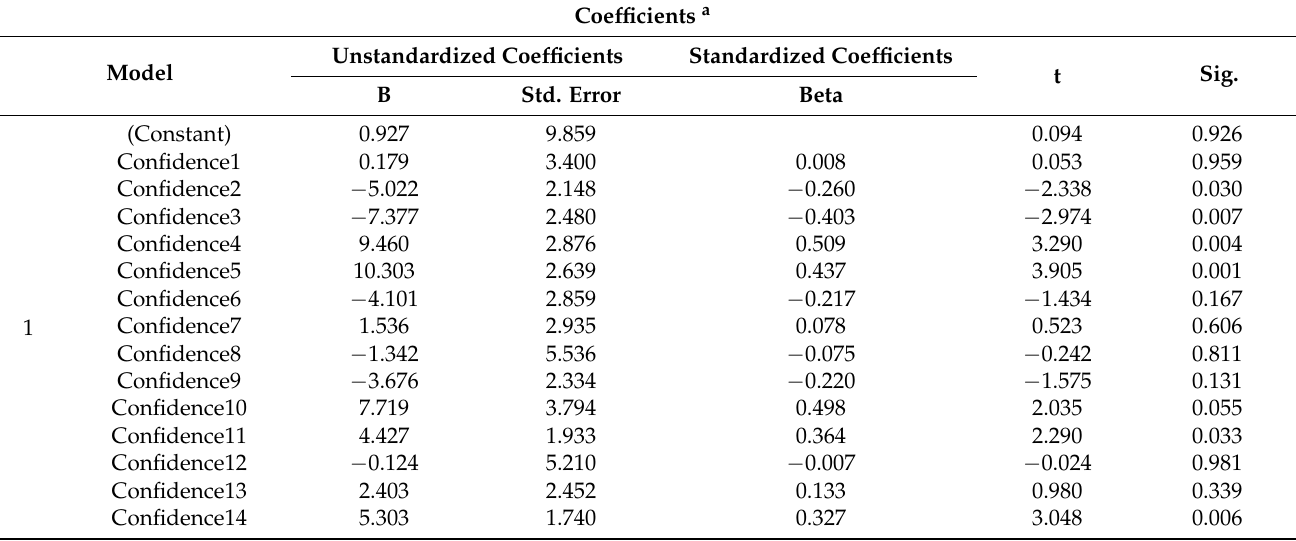
Table 7. Regression equation table for the confidence